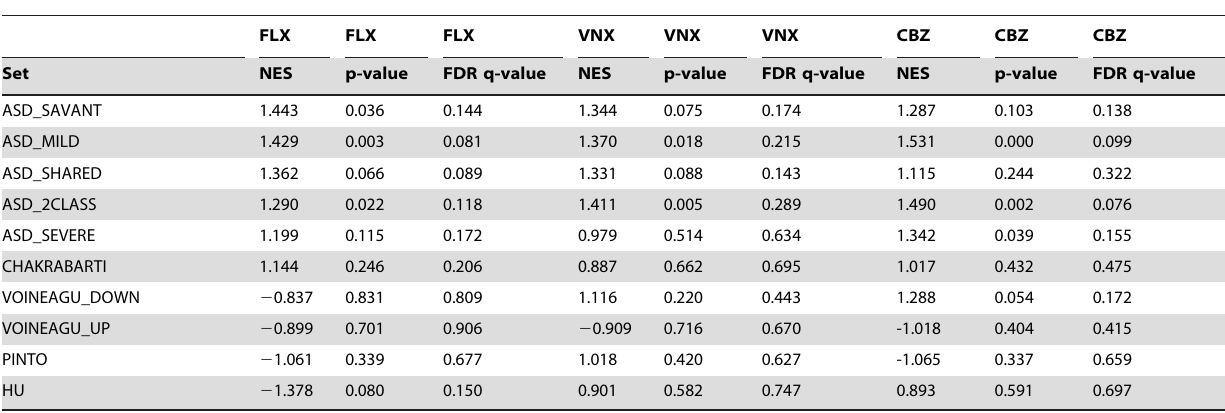
Table 6. Single drug treatments & ASD sets.